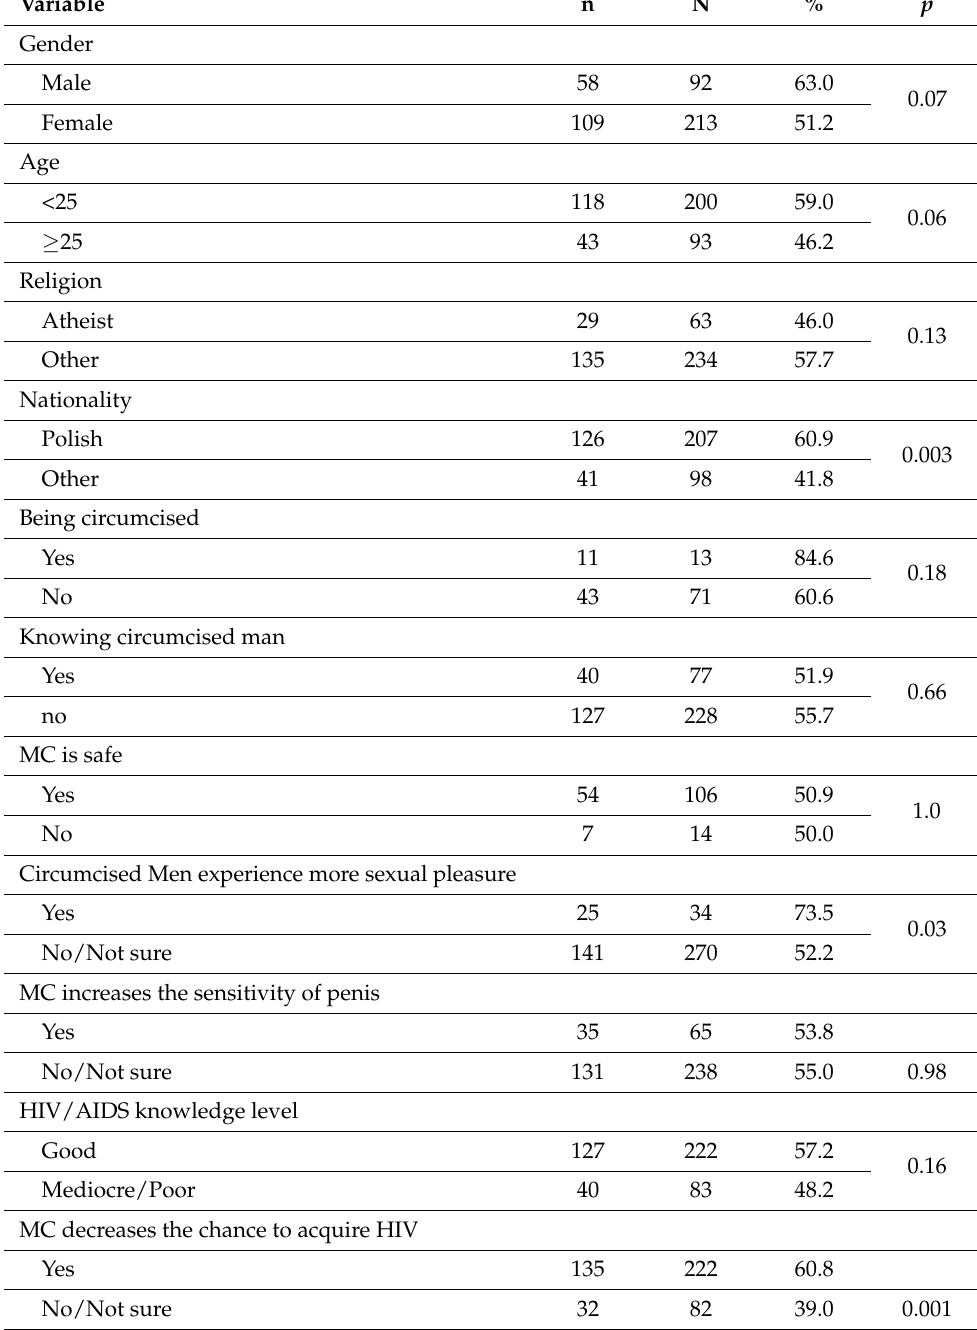
Table 3. Bivariate analyses of determinants of final year medical students’ willingness to recommend male circumcision (MC) to adults at high risk for HIV, Poland, 2013–2016; n =